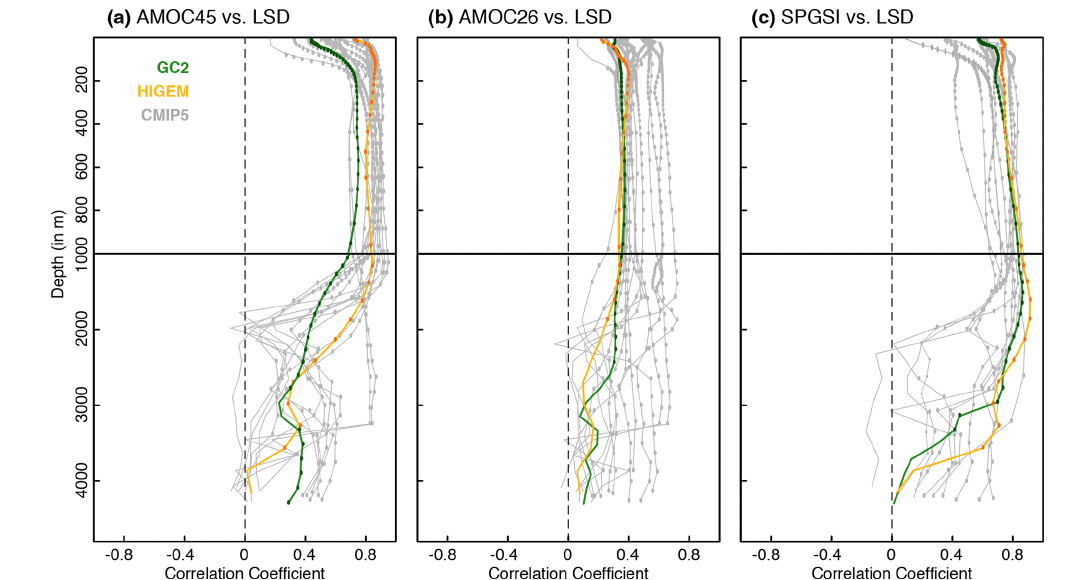
Figure 5. (a) Maximum correlation (for any lag between 0 and 10 years) between the AMOC45 index (after the Ekman transport is removed) and Labrador Sea densities as a function of depth for all the simulations. Coloured dots indicate correlations that are significant at the 95% confidence level. (b–c) The same as in (a) but between the AMOC26 index and LSD and between the SPGSI and LSD, respectively.